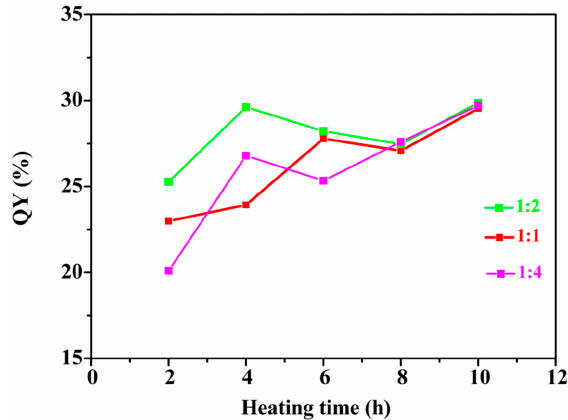
Figure 2. The quantum yields (QY) of ZnO QDs synthesized under different [Zn 2+ ]/[OH − ] molar ratios and heating times.